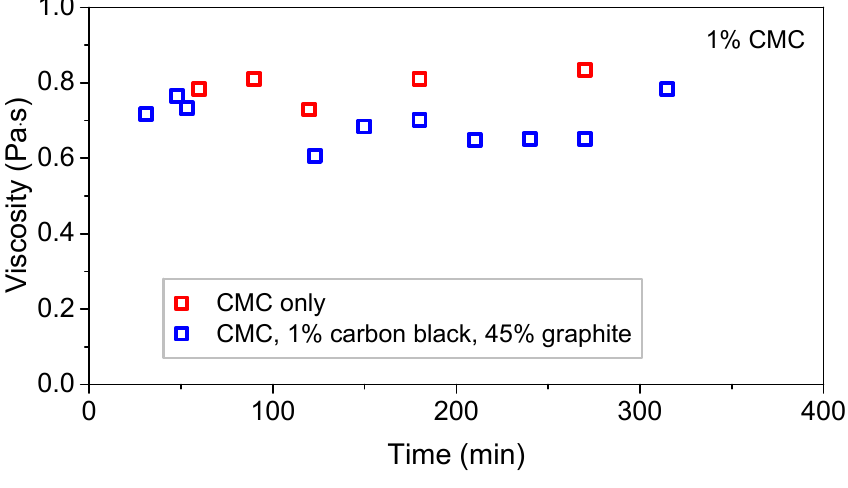
Figure 2. Viscosity versus mixing time of 1% CMC slurries at 10 RPM.